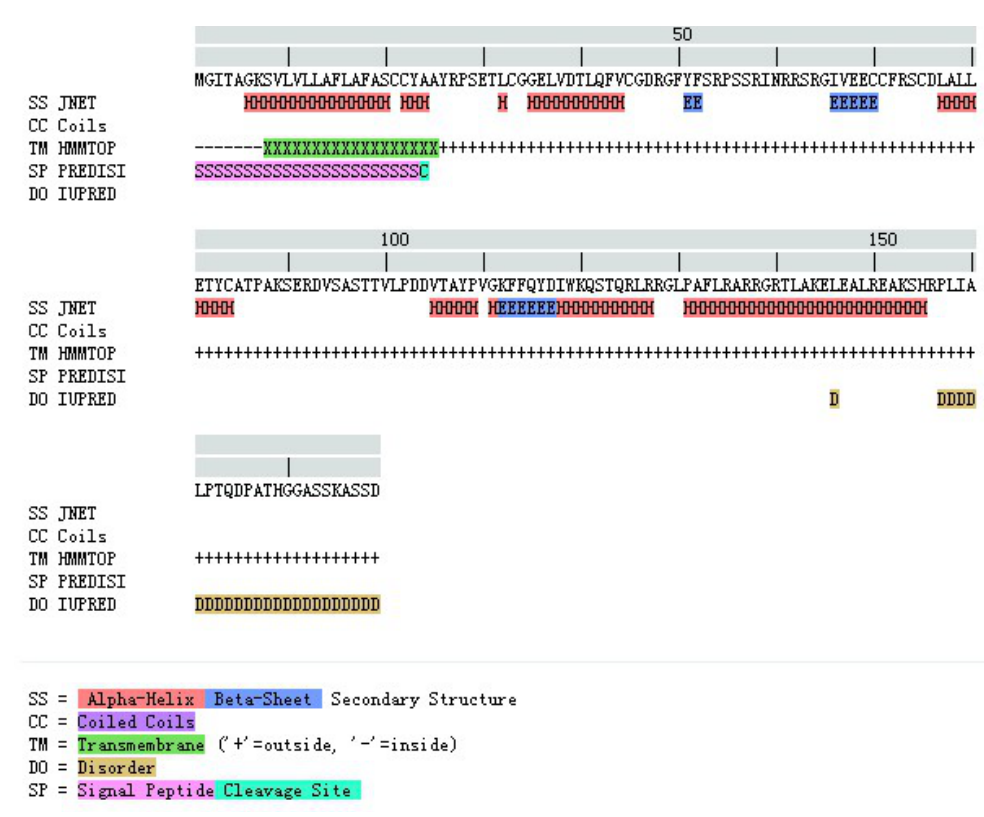
Figure 5. The secondary structure annotation sites of the yak IGF2 sequence using Bioinformatics Toolkit Quick2D